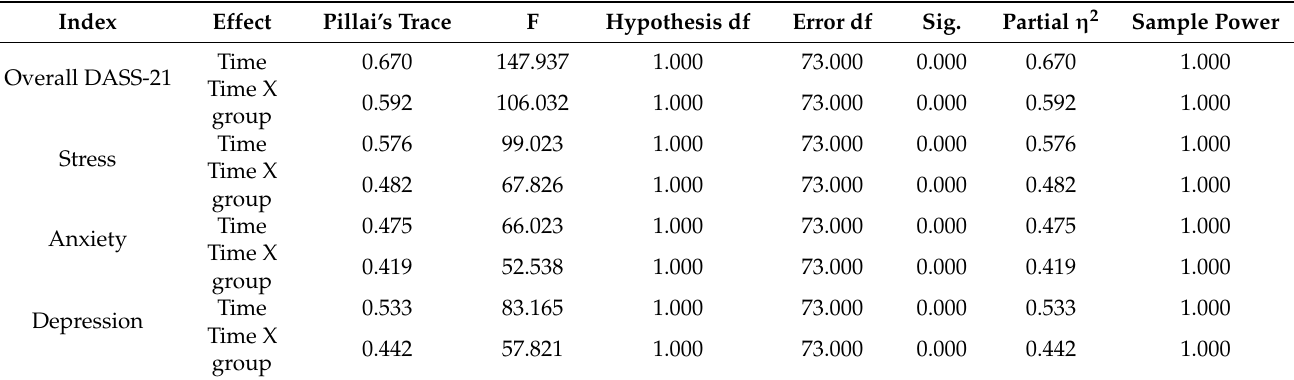
Table 3. Multivariate